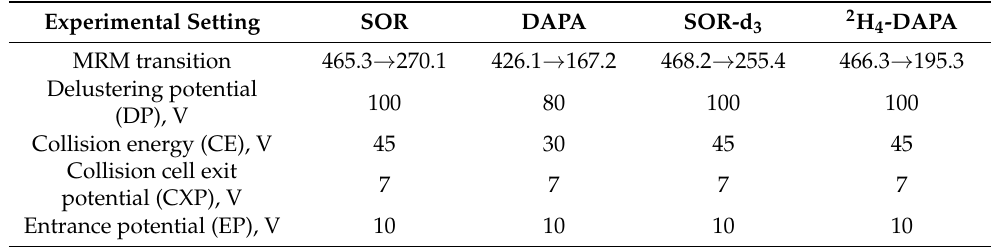
Figure 5. Product ion mass spectrum of SOR ( A ), SOR-d 3 ( B ), DAPA ( C ), and 2 H 4 -CAPA ( D ). Table 5. Experimental setting for the tandem mass-spectrometer for the analytes and internal